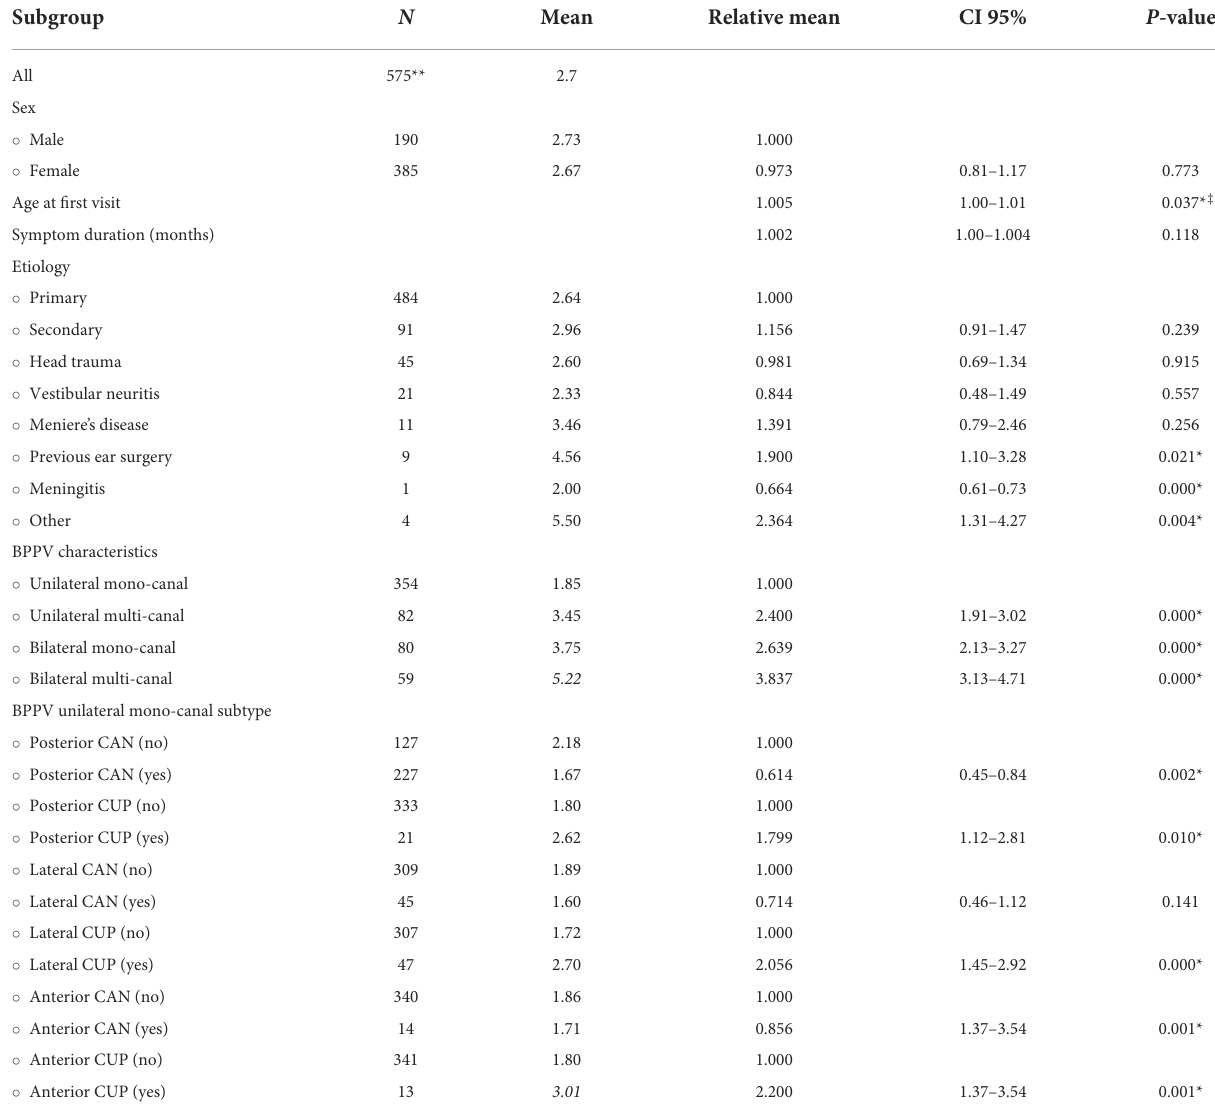
TABLE 4 Number of required